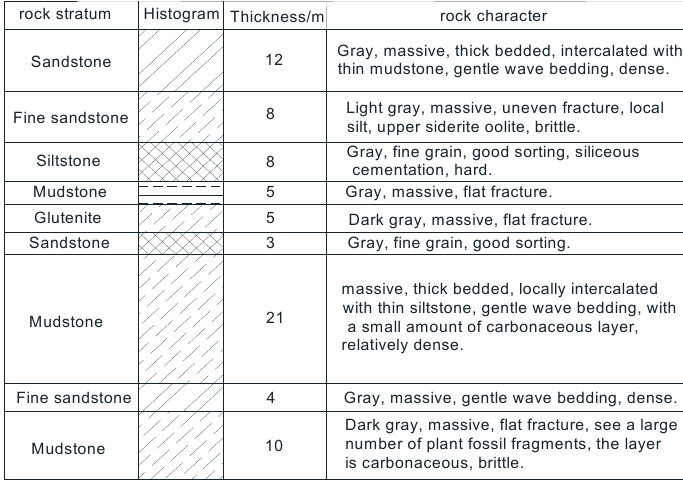
Figure 1. Comprehensive histogram of rock strata.